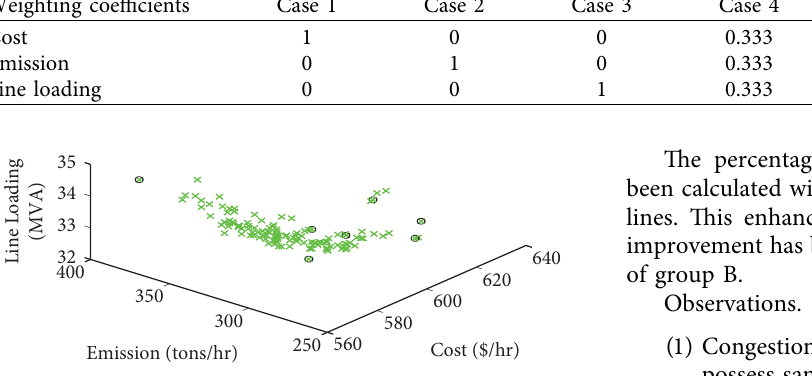
Figure 2: Pareto-optimal front for strategy A